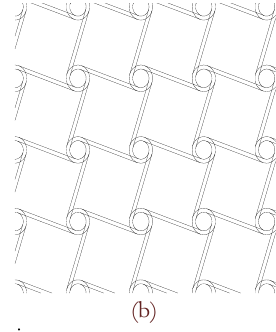
Figure 1: (a) Hexachiral lattice; (b) tetrachiral